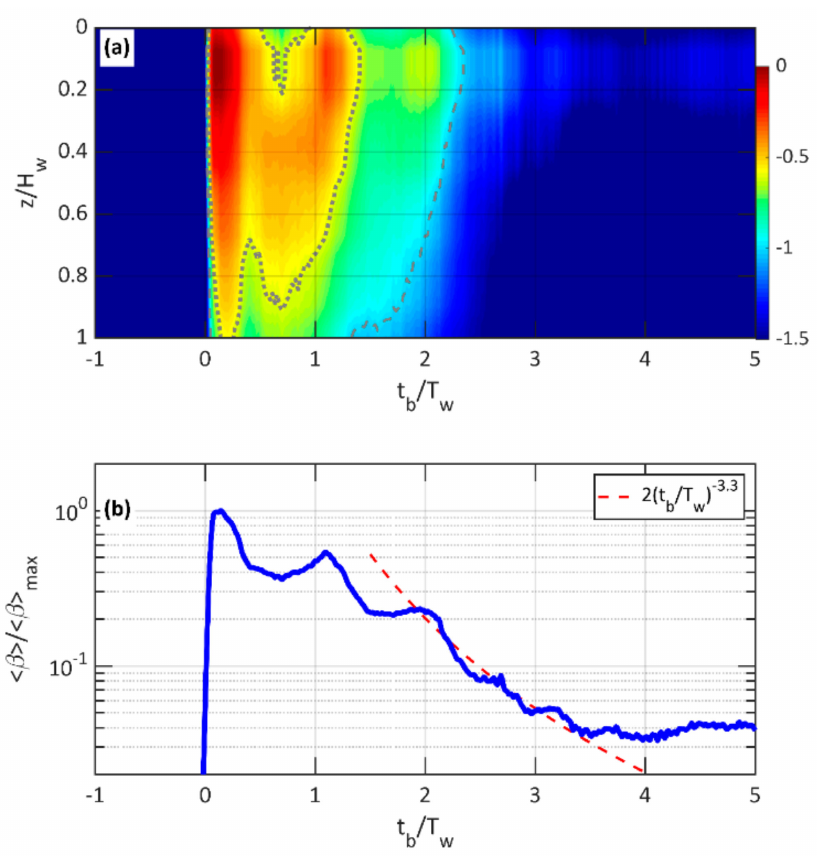
Figure 7. ( a ) Time-depth plot of ensemble-averaged profiles normalized by the peak value, β / β max . Elapsed time ( t b ) and depth ( z ) are normalized by wave period ( T w ) and breaking wave height ( H w ), respectively. The gray dotted and dashed lines represent the contour lines of β / β max of 0.25 and 0.1, respectively. ( b ) Near-surface depth-averaged LiDAR intensity (cid:104) β (cid:105) normalized by the maximum mean intensity of the breaking event. The dashed line represents a power-law decaying, ∼ a ( t ) c , where a = 2 and c = − (cid:104) β (cid:105) / (cid:104) β (cid:105) b / T w max